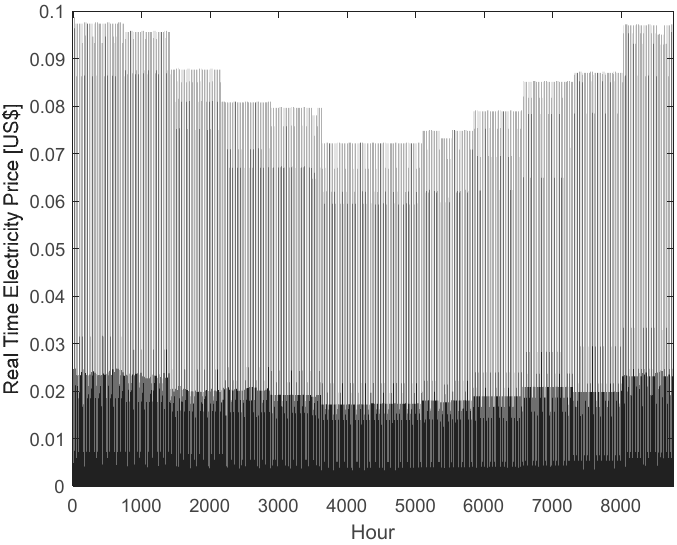
Figure 8. RTP based on the TOU prices and load consumption.